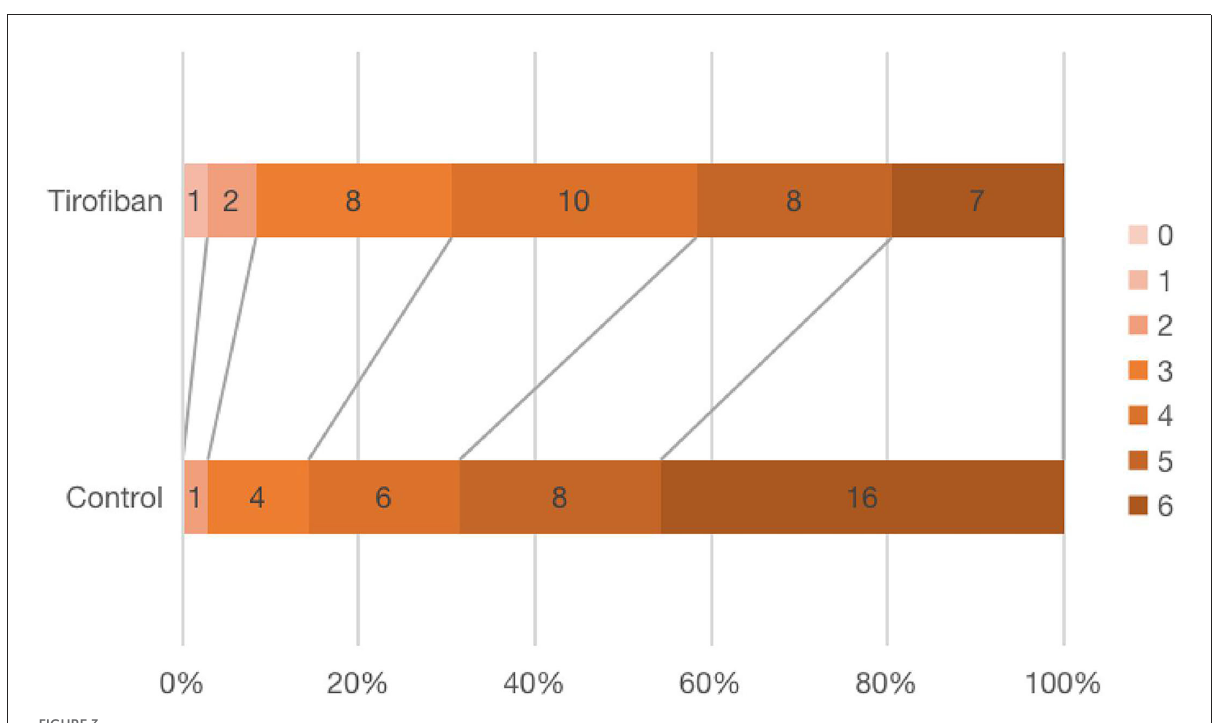
FIGURE3 Distribution of the modified rankin scale (mRS) scores at 90